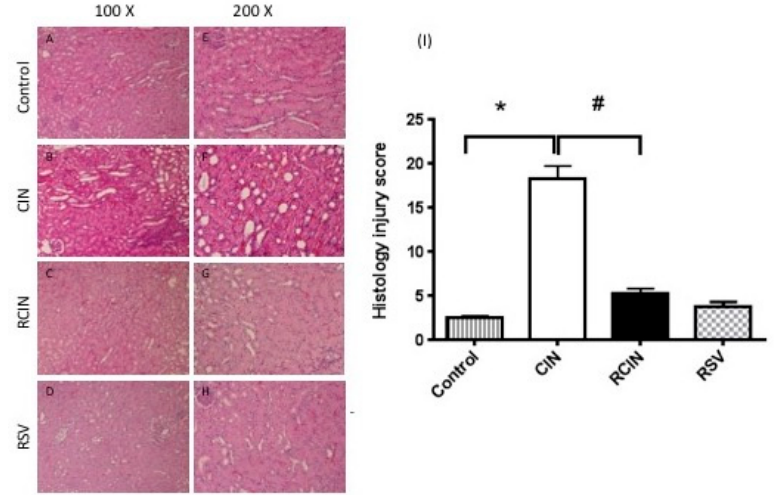
Figure 2. Histopathological findings of rat kidney after CIN had been induced. Kidney tissues of the CIN and RCIN rats were collected 24 h after contrast nephropathy had been induced. Representative photomicrographs of histologic staining with hematoxylin and eosin in the corticomedullary junction at × 100 (left, A–D ) and × 200 magnification (right, E–H ). ( A and E ) Control rats. ( B and F ) Rats treated with contrast. ( C and G ) Rats treated with contrast after resveratrol treatment. ( D and H ) Control rats pretreated with resveratrol. RSV = resveratrol; CIN = contrast-induced nephropathy; RCIN = resveratrol before contrast-induced nephropathy. ( I ) Histologic scores of contrast nephropathy. Histopathology scoring was assessed in a blinded fashion. The scoring system reflecting the grading of tubular necrosis, loss of brush border, cast formation, and tubular dilatation in 10 randomly chosen, non-overlapping fields (200 × ) was as follows: 1, <10%; 2+, 10–25%; 3+, 26–75%; and 4+, >75%. The score in the CIN group was 18.3 ± 3.4, compared with 2.5 ± 0.5 in the control group. Treatment with resveratrol (RCIN group) before contrast significantly reduced the histologic injury score to 5.2 ± 1.5 versus RCIN. All statistical analyses were performed by Kruskal-Wallis test, followed by Dunn’s multiple comparison post hoc test ( n = 8 for each group). *: p < 0.05 versus control; #: p < 0.05 versus RCIN.